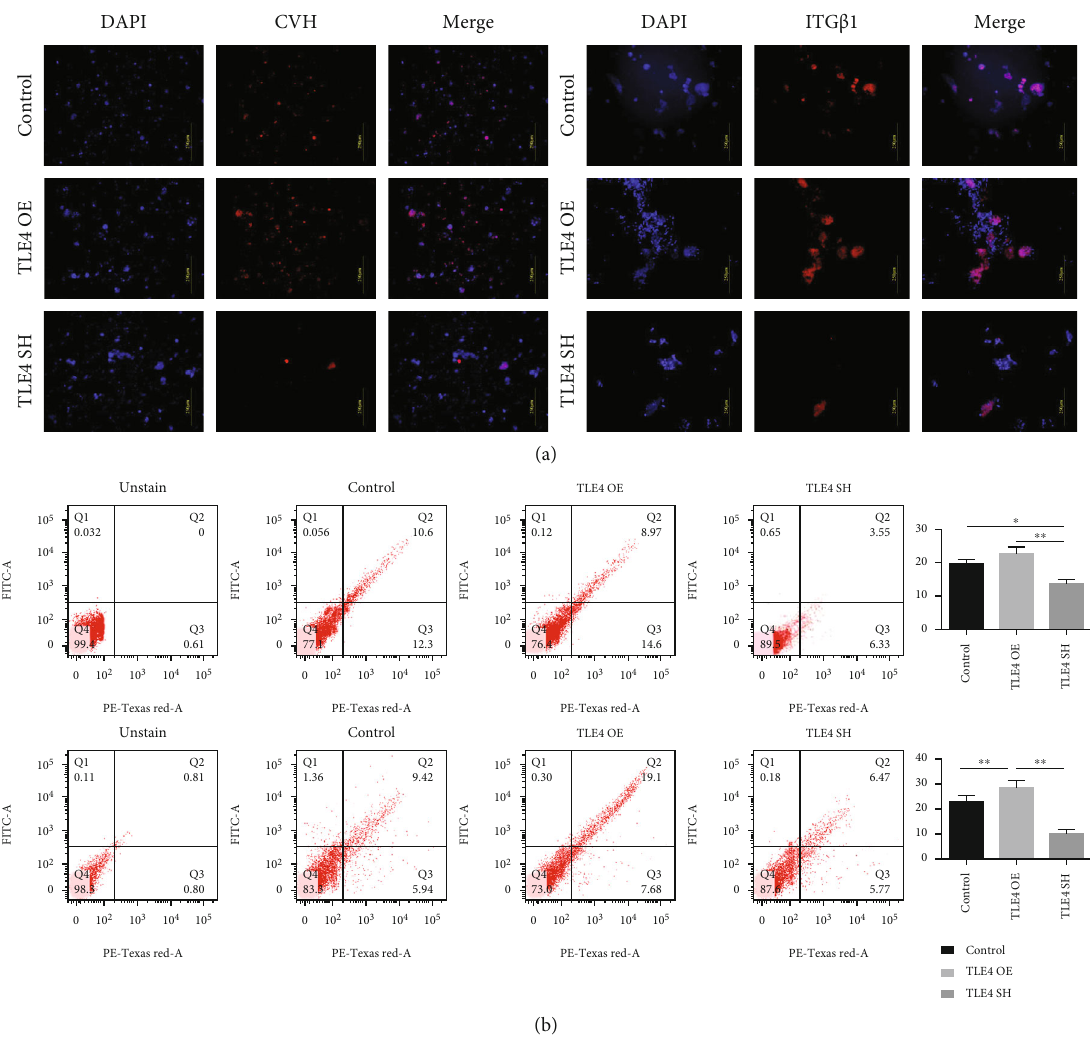
Figure 7: TLE4 function veri fi cation in vitro. (a) Immuno fl uorescence test on day 4 and day 10. (b) Flow cytometry analysis on day 4 and day 10, and quanti fi cation of positive cells; here, PE-Texas Red means TRITC